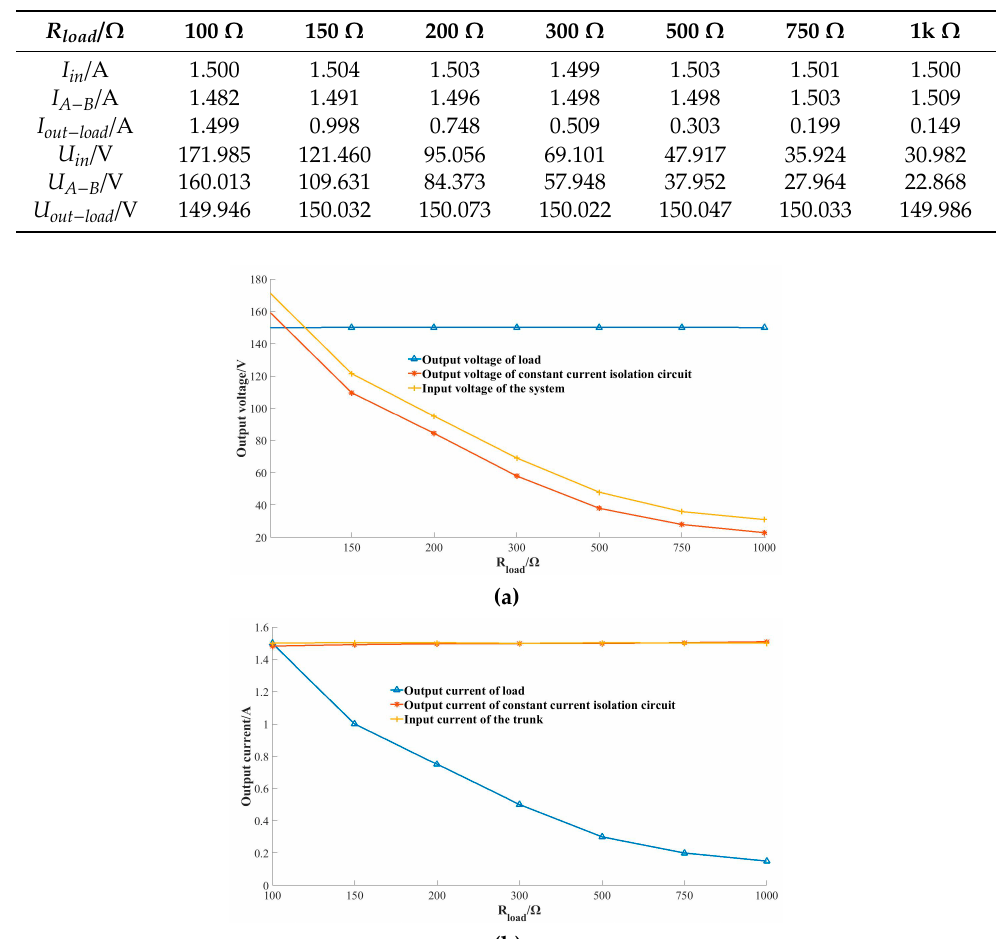
Table 2. Experimental test data in the di ff erent resistance values of load.